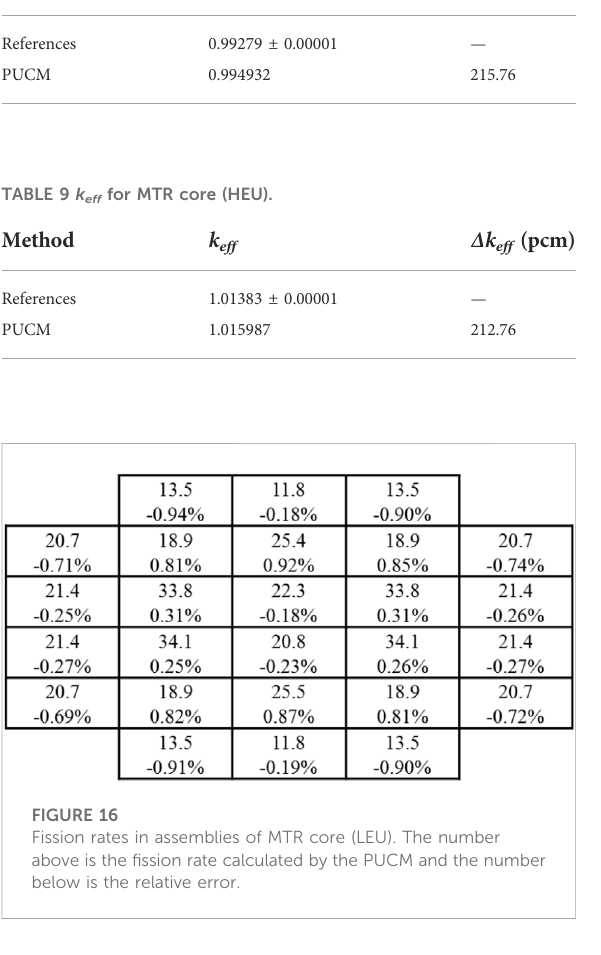
FIGURE 18 Fission rates in assemblies of MTR core (HEU). The number above is the fi ssion rate calculated by the PUCM and the number below is the relative error.